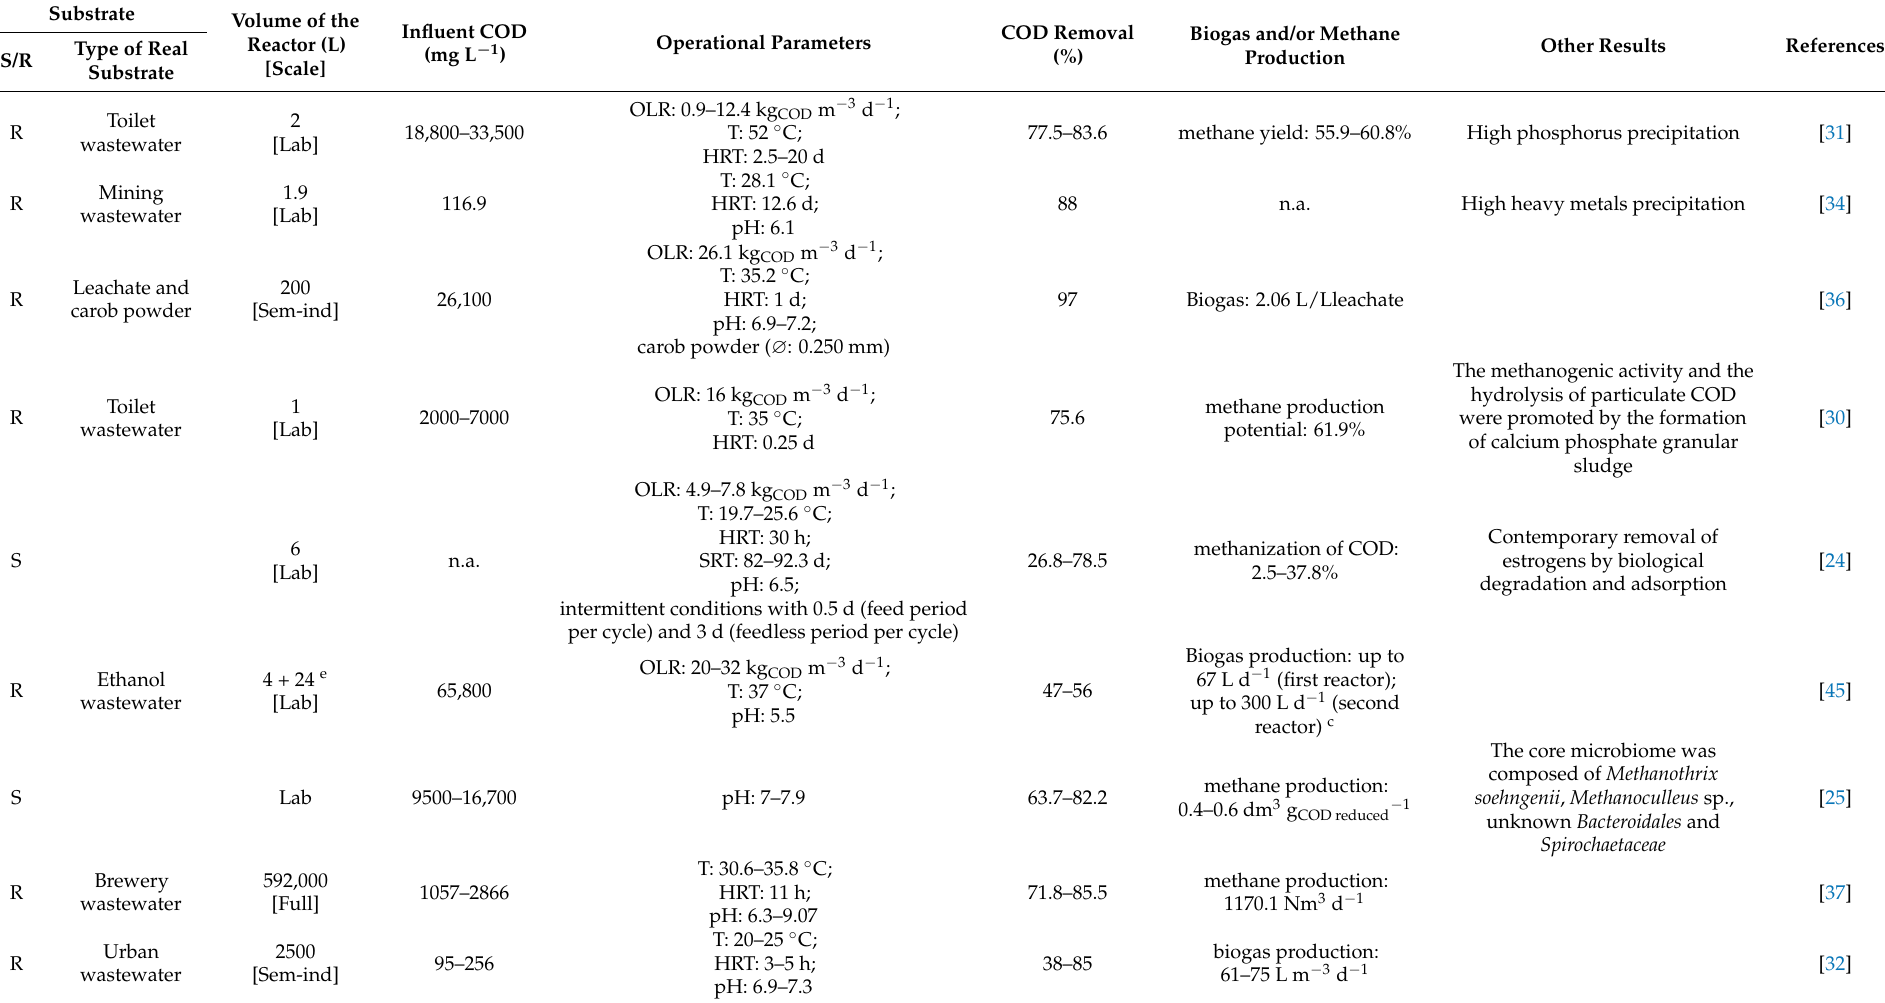
Table 1. Several applications of UASB technology for organic substance removal and biogas production. S: Synthetic substrate; R: real matrix. n.a.: not available. a : referred only to soluble COD. b : value deduced by figure analysis. c : tests were performed in batch with granular sludge extracted from a UASB. d : expressed as BOD. e : two reactors in series. ∅ :